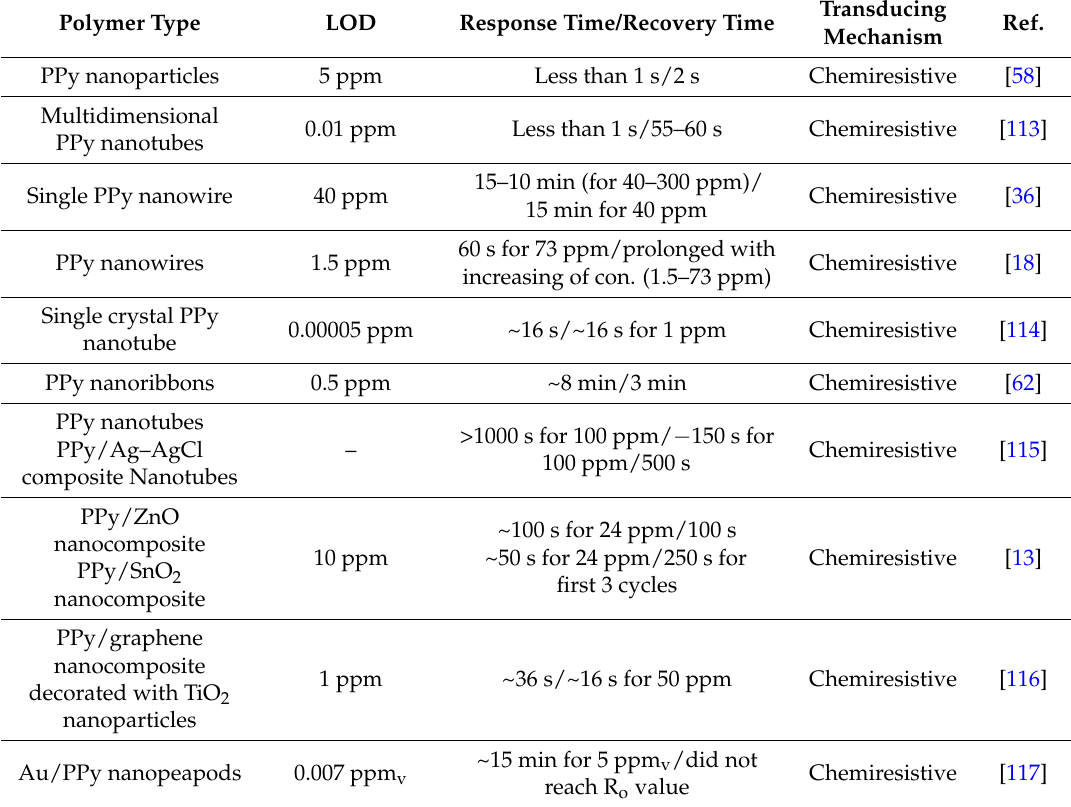
Table 3. Overview of PPy used as active layers for detection of ammonia at room